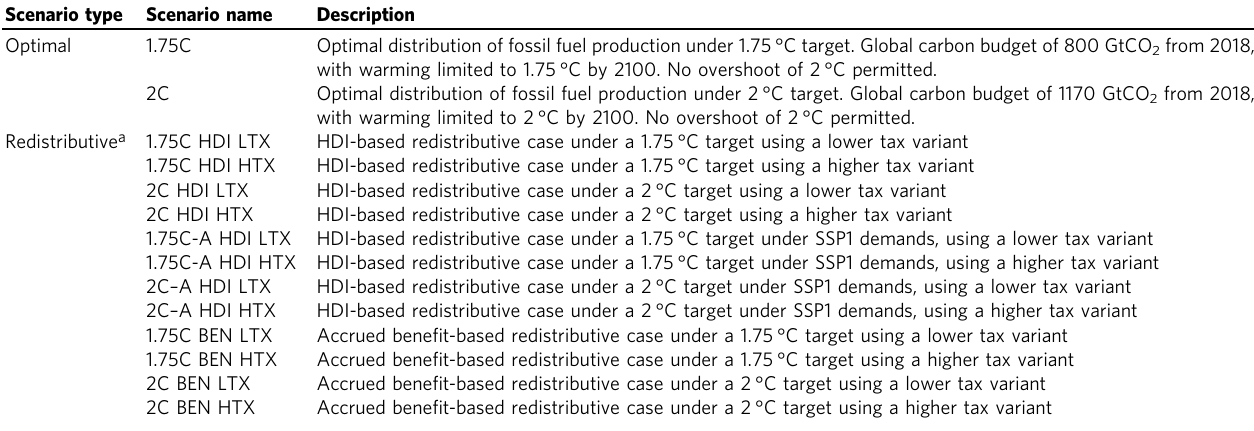
Table 3 List of scenarios modelled in